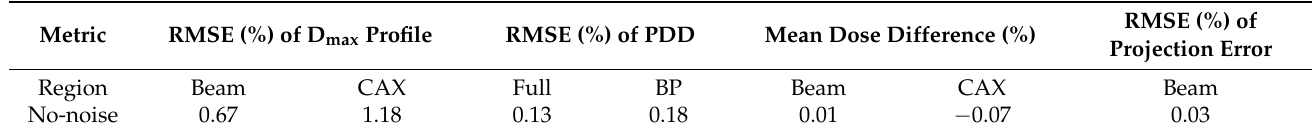
Table 1. No-noise simulation reconstruction accuracy metrics. The tomographic reconstruction of DHI-based OC dosimeter dose measurement for a no-noise simulation was performed before comparing the reconstructed and MC-simulated dose distributions to determine the reconstruction accuracy.